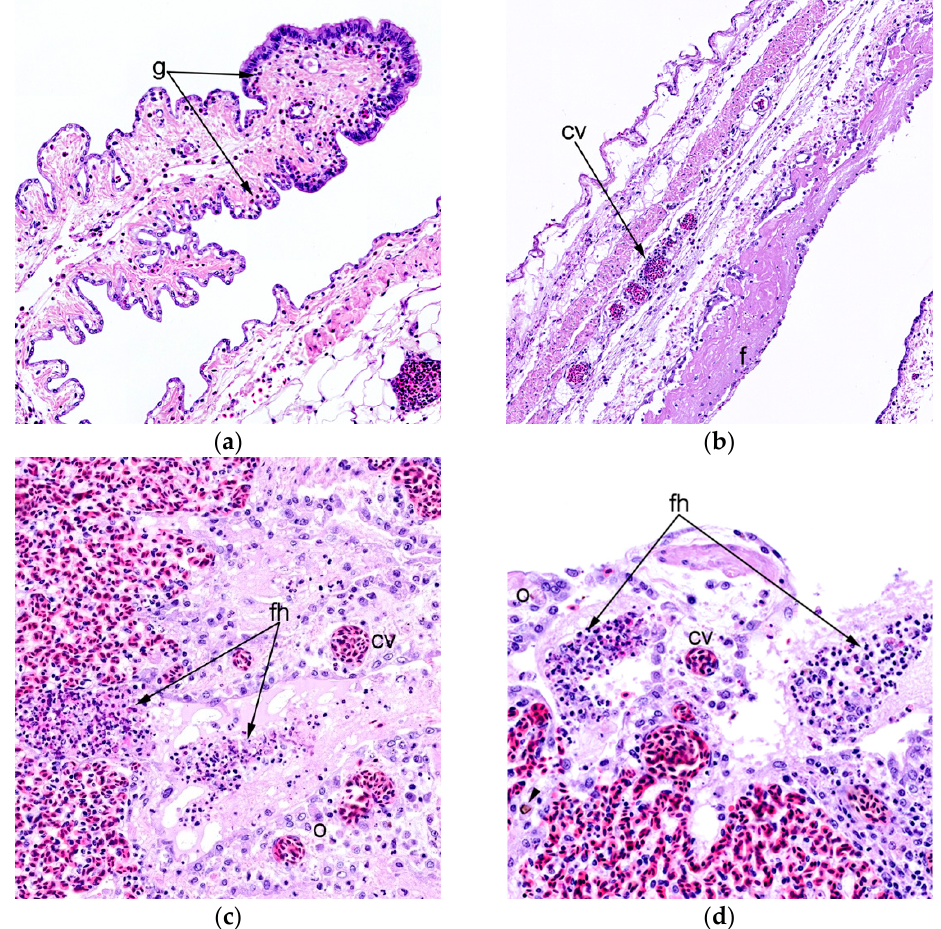
Figure 3. ( a ) Marked granulocytic (g) (presumed heterophils) infiltration of an air sac ( b ) Air sac with inflammation characterised by infiltration of granulocytes, most likely heterophils, as well as mononuclear inflammatory cells, congested vessels, oedema, and a layer of dense fibrinous (f) exudate on the luminal surface. A sparse number of cells embedded within the fibrinous exudate and necrotic focal areas is evident beneath the layer. ( c ) Fibrinoheterophilic (fh) exudate, cell debris and oedema (o) are present within the atria and infundibula of the parabronchus. Mild inflammation is present in the interatrial septa together with congested vessels (cv) ( d ) Similar to ( c ). A fungal fragment (arrowhead) is seen within the infundibulum. All lesions presented are from unvaccinated birds challenged with E. coli (positive control = nv-c group).